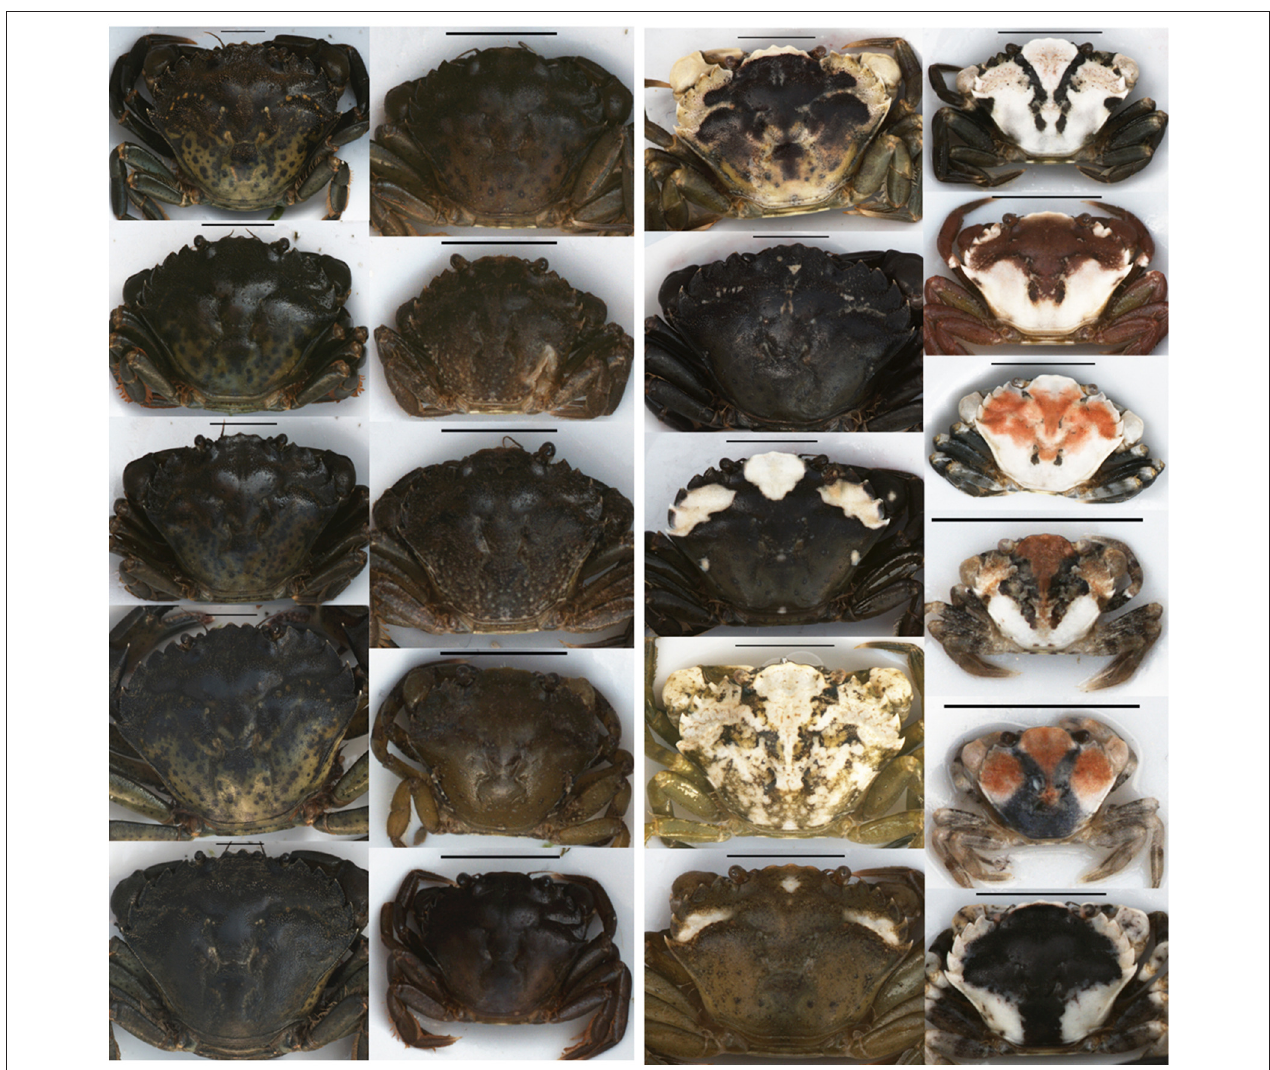
FIGURE 3 | Shore crabs ( Carcinus maenas ) differ depending on the habitat in which they live. Individuals from relatively uniform brown-green mudflats (left two columns) are more uniform and of similar color to the substrate, whereas those from colorful rock pool habitats (right two columns) are much more diverse and patterned. In each case, the column of crabs on the left hand side of the pairs are adults, which are often more uniform and less variable than juveniles. Images modified from Stevens et al.